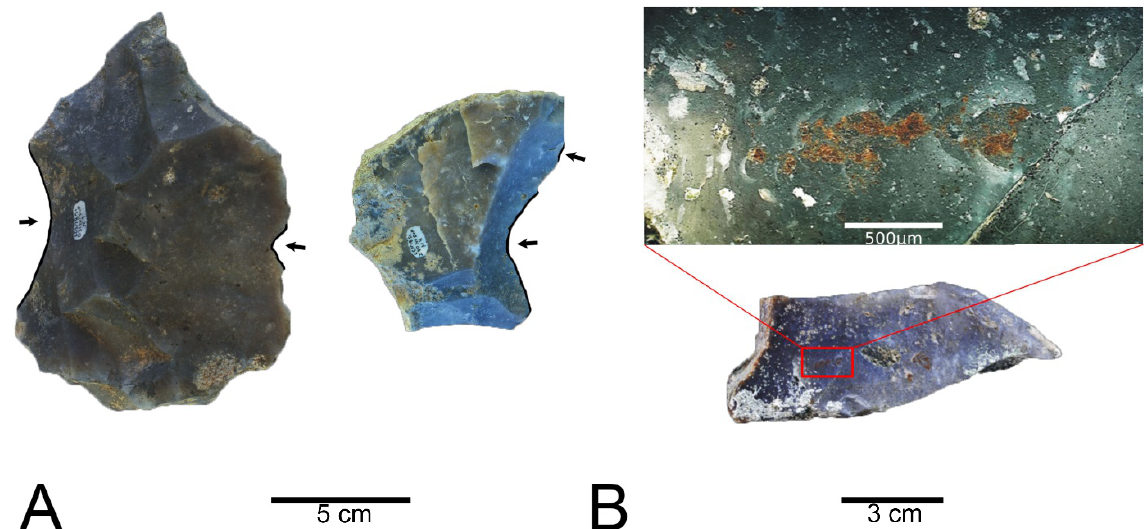
Figure 11. Evidence of the use of metal hammers. A) Wide flake mouths and large bulbar scar. Left, polyhedral core LGN’18_sup_D31_1; right, core on flake LGN’18_sup_I30_4. B) Oxidation and percussion cones observed through the microscope (LGN’18_sup_H31_4) (Photographs by J. L.